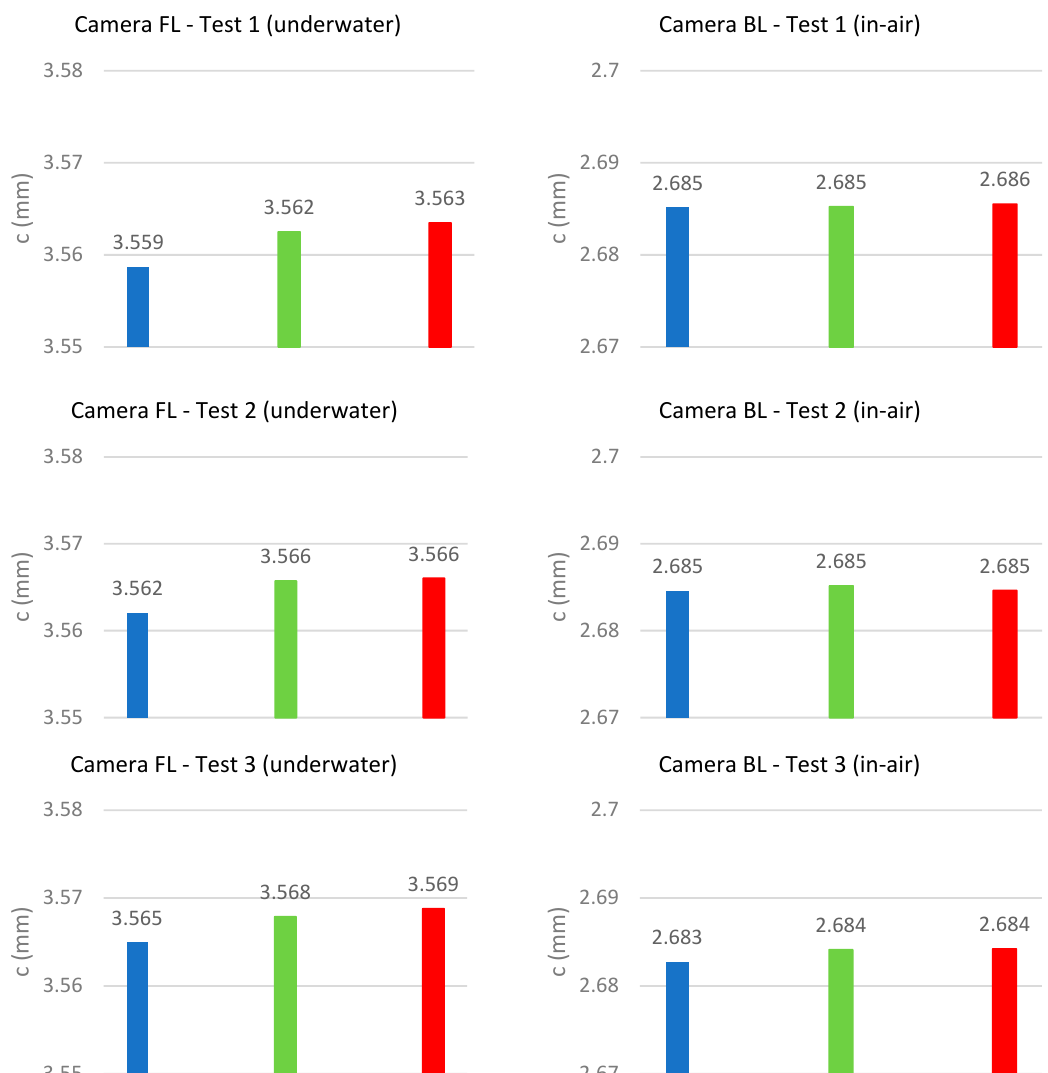
Figure 11. Comparison of the calculated principal distances for the camera FL underwater ( left column) and the camera BL ( right column) for the overall three repeats (rows) using the CMB adjustment. The order of all diagrams is blue band, green band, red band (indicated by colour).